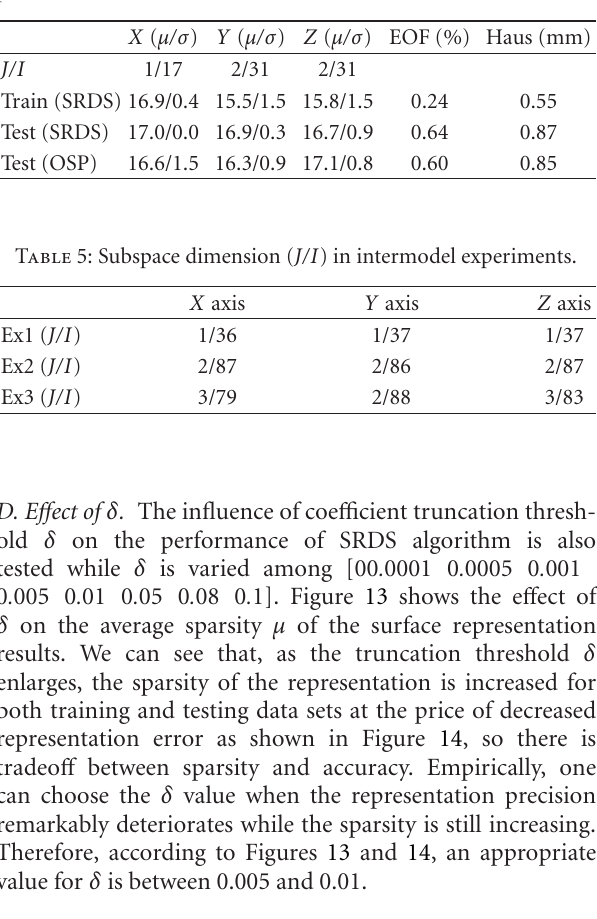
Table 4: Subspace dimension and sparsity ( μ/σ ) for intramodel ex- periment.